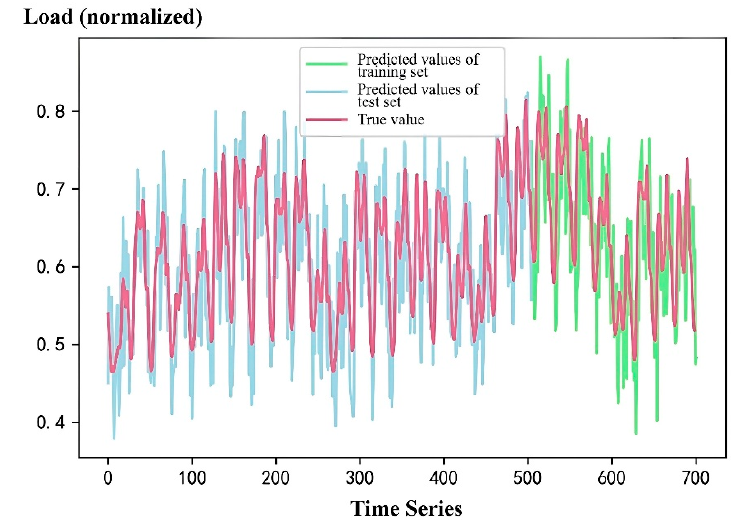
Figure 12. Prediction results.